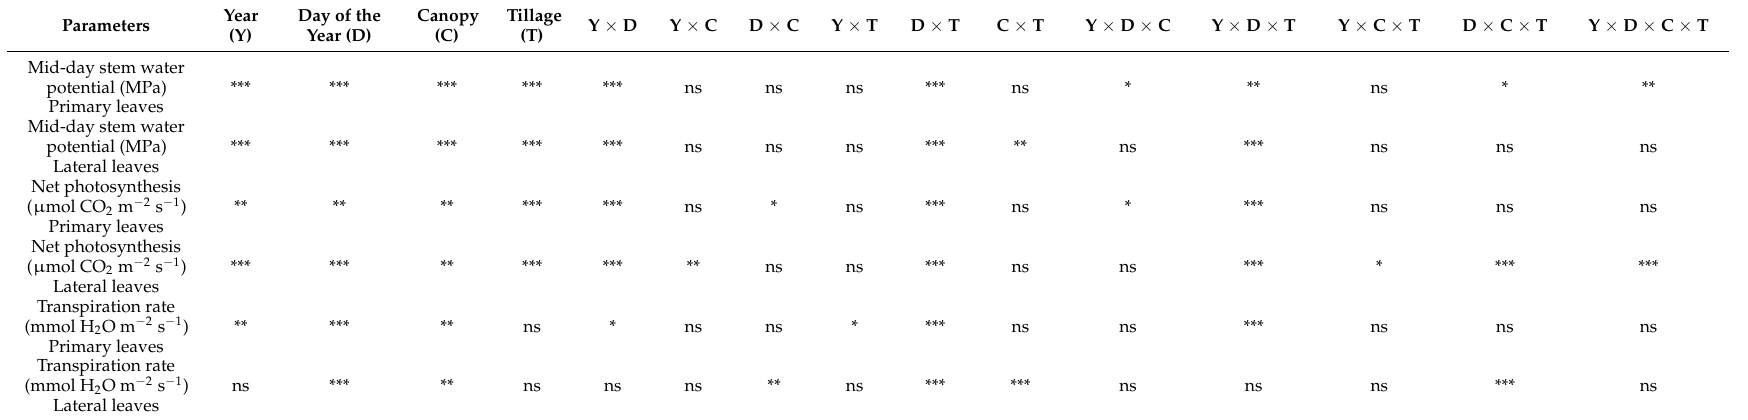
Table 2. Tukey’s post-hoc test ANOVA on yield characteristics and main berry quality attributes. Interactions are indicated by: * Significant p < 0.05; ** Significant p < 0.01; *** Significant p < 0.001.